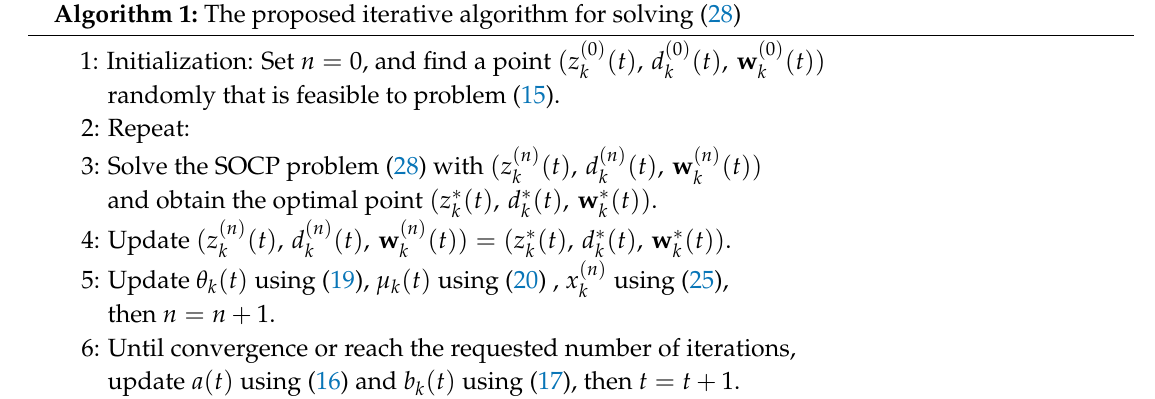
Algorithm 1: The proposed iterative algorithm for solving